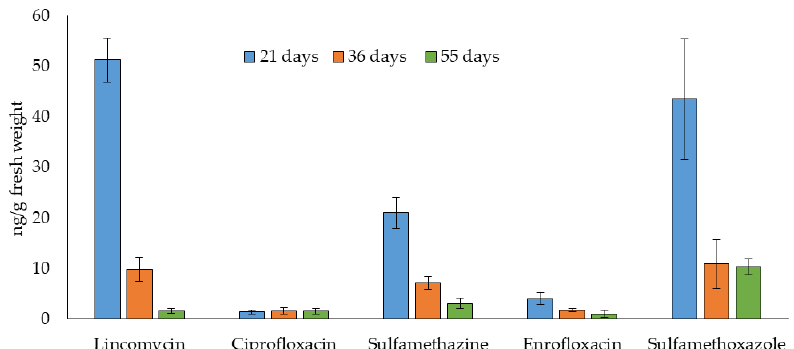
Figure 3. Antibiotic levels (ng / g fw) in lettuce leaves harvested 21, 36, and 55 days after planting. Table 2. Uptake factor (UF) of the antibiotics after 21, 36, and 55 days of growth. (Uptake factor values were calculated from equation: UF = CP/CS, where Cp is the concentration in plant material and Cs is the concentration added to soil).